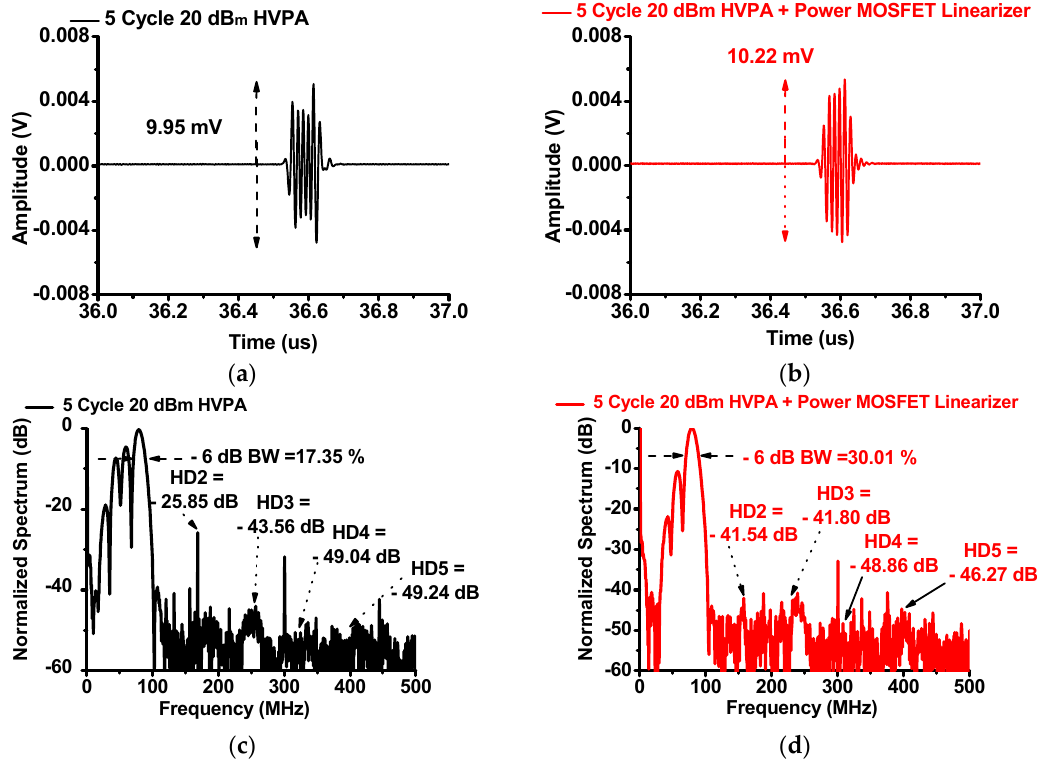
Figure 11. The echo signal amplitude when using the HVPA ( a ) without and ( b ) with the power MOSFET linearizer and the spectrum of the HVPA ( c ) without and ( d ) with the power MOSFET linearizer when five-cycle 20 dB m input power is applied.